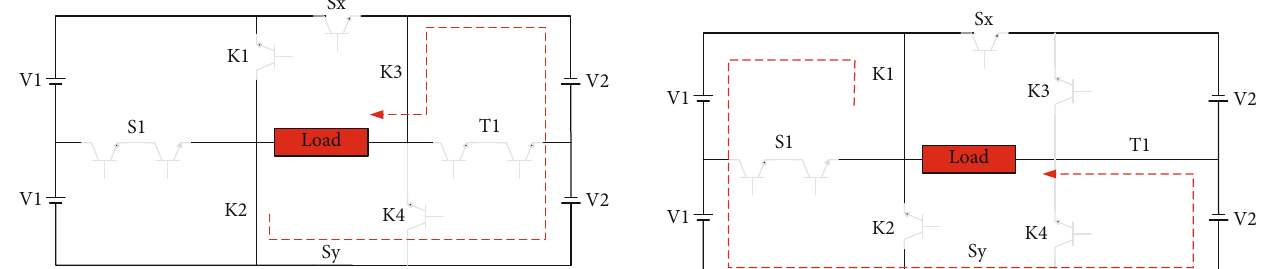
Figure 10: Current fl ow for the 8 th switching pattern.